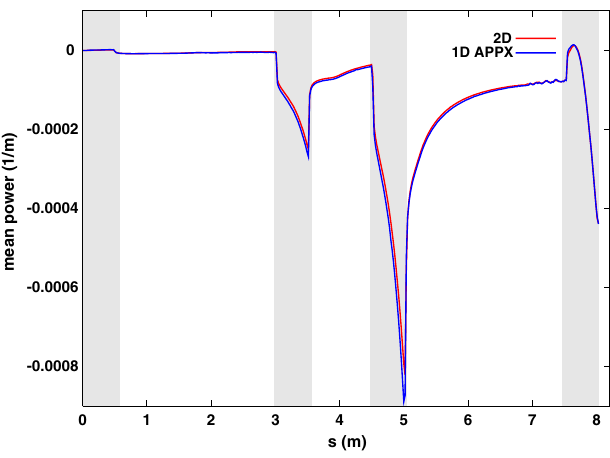
FIG. 16. Comparison of the mean power calculated with the 2D model [11] and the 1D field approximation scheme [28] for the FERMI@Elettra first bunch compressor. The 1D field ap- proximation scheme is in very good agreement with the 2D model. The simulations have been done with the TFCT method.